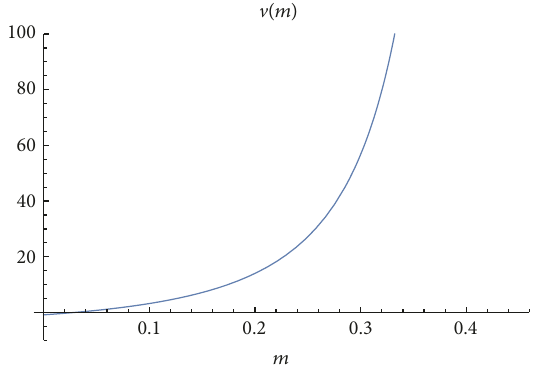
Figure 10: Velocity V (𝑚) (46) of solution (4) as function of 𝑚 . Table 1: Examples of values of 𝐴, 𝐵,𝐷, V , and 𝐿 for 𝑧 = 𝑧 2 case. 𝛼